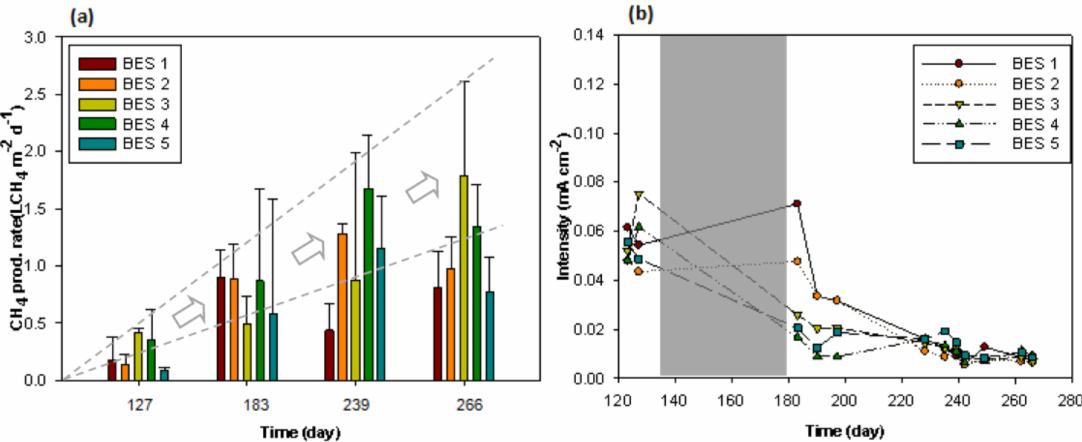
Figure 6. ( a ) CH 4 production rate of individual EMG-BES (after inoculation), operated at a constant voltage of 0.7 V and fed with synthetic medium; ( b ) Current density consumption measured during the same period. No electrical data were collected within the experimental period reported in